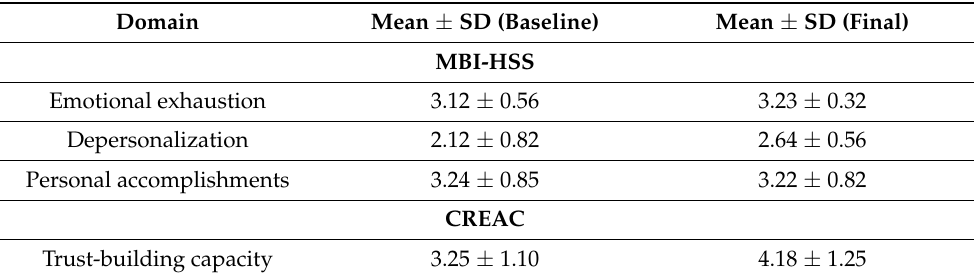
Table 10. Average results of the professional survey intermediate